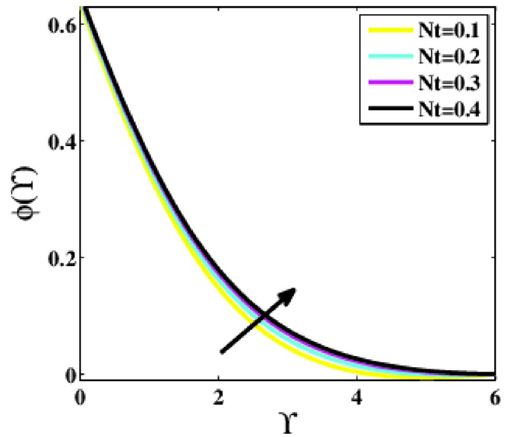
Figure 19. Plots of φ(ϒ) for Nt .